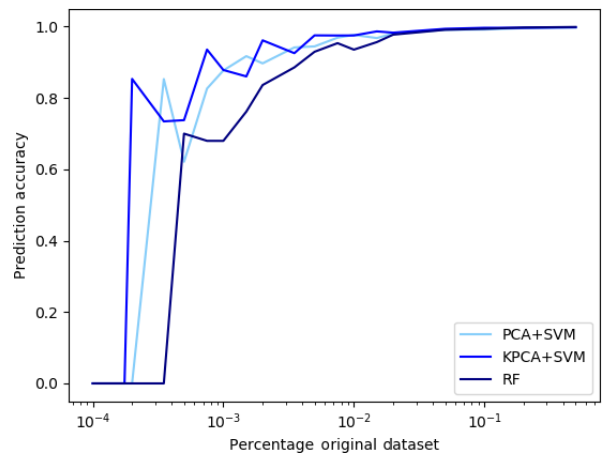
Figure 7. Prediction accuracy using subsets of the CSDB of differ- ent